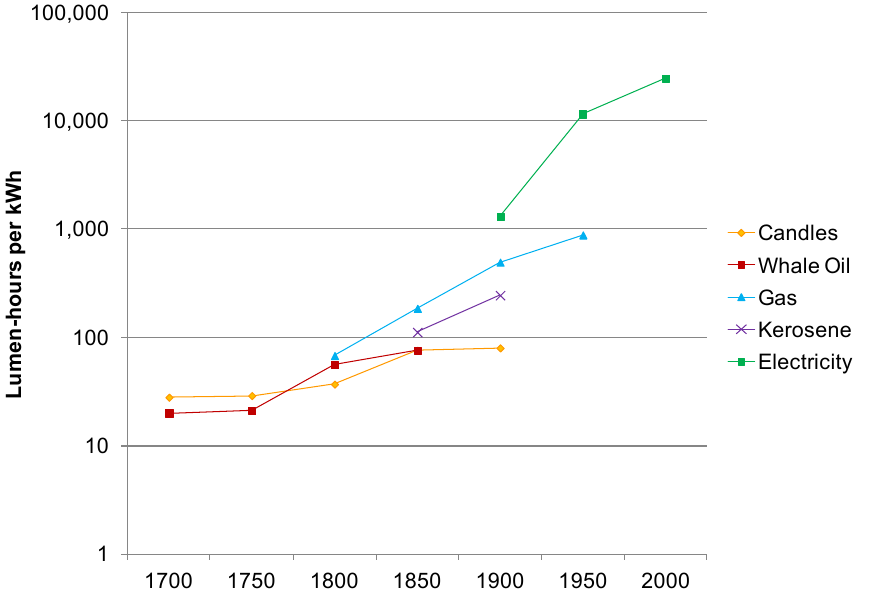
Figure 19. Efficiency of lighting technologies, 1700–2000. Source: